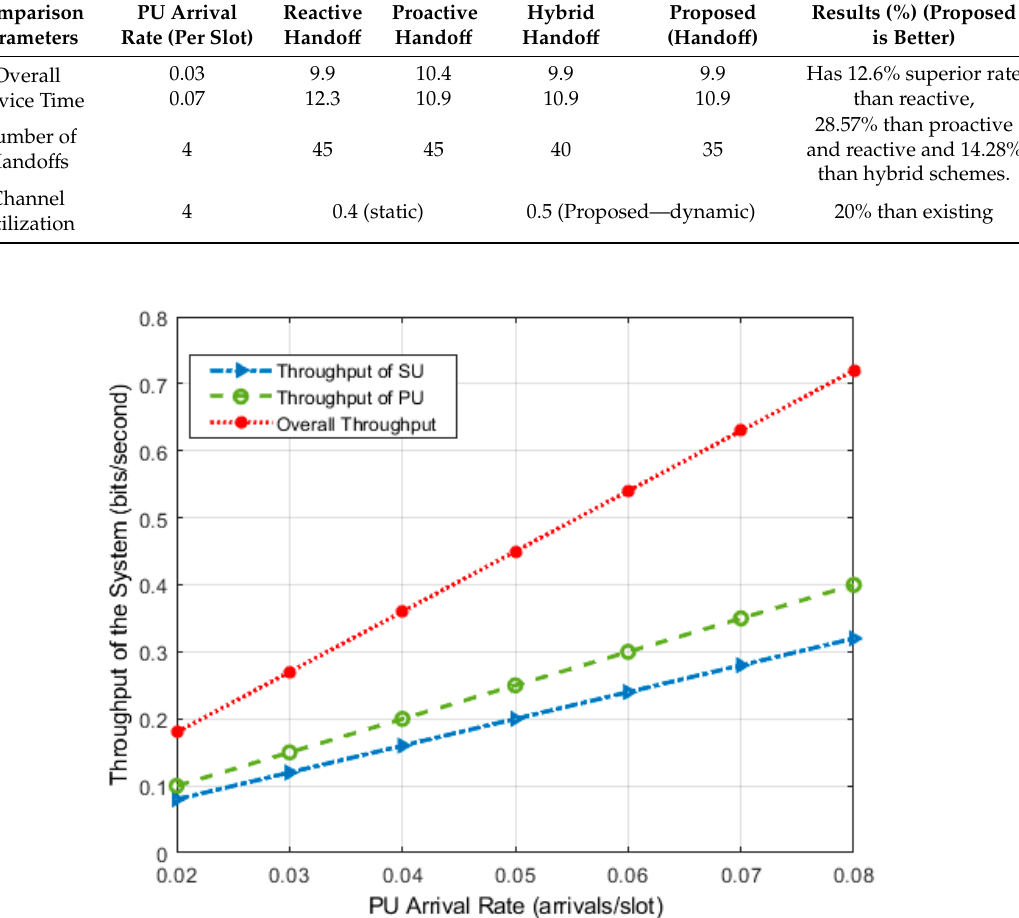
Figure 10. Throughput analysis of the PUTPOSH approach w.r.t. the function of PU